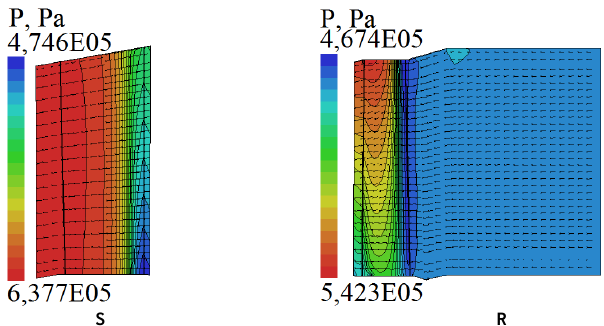
Figure 26. Static pressure contours and velocity vectors in the meridional plane at mid blade-to-blade distance for the stator and rotor of stage 8